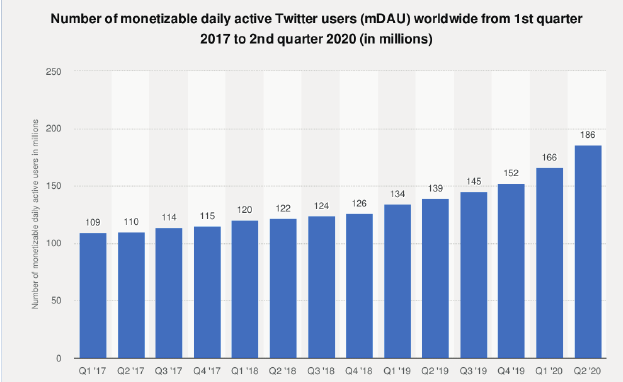
Fig. 1. Twitter statistics for active number of users from Q1 2017 to Q2